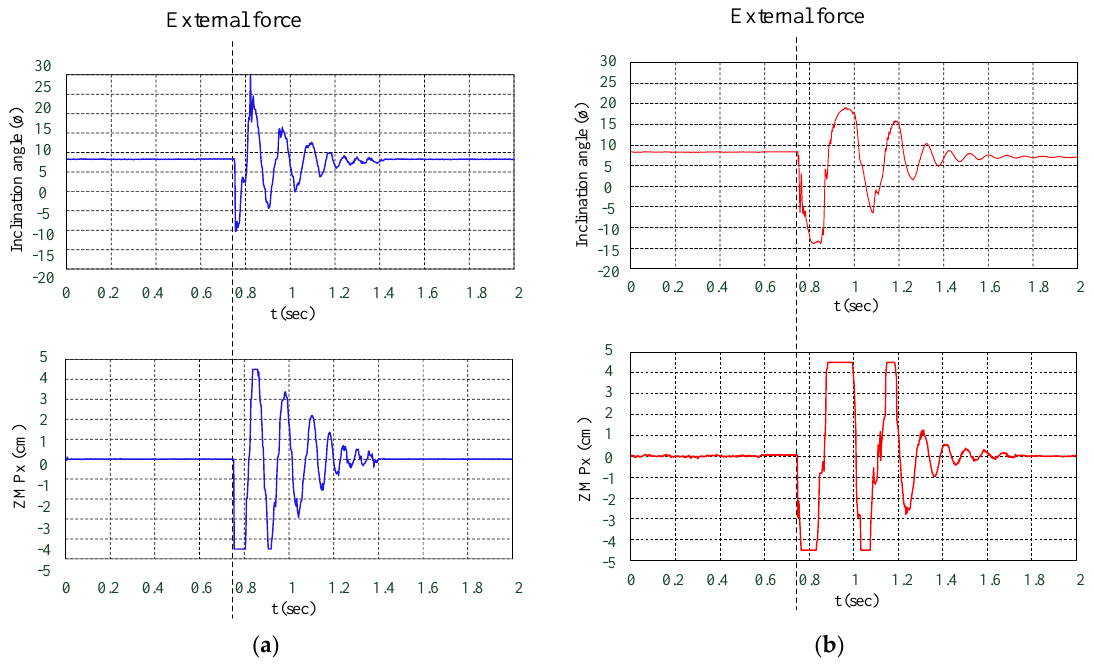
Figure 15. Experimental results of the TKU-X robot hit from the front by a baseball or a volleyball at 0.75 s when the balance control method is disabled. ( a ) Baseball. ( b ) Volleyball.